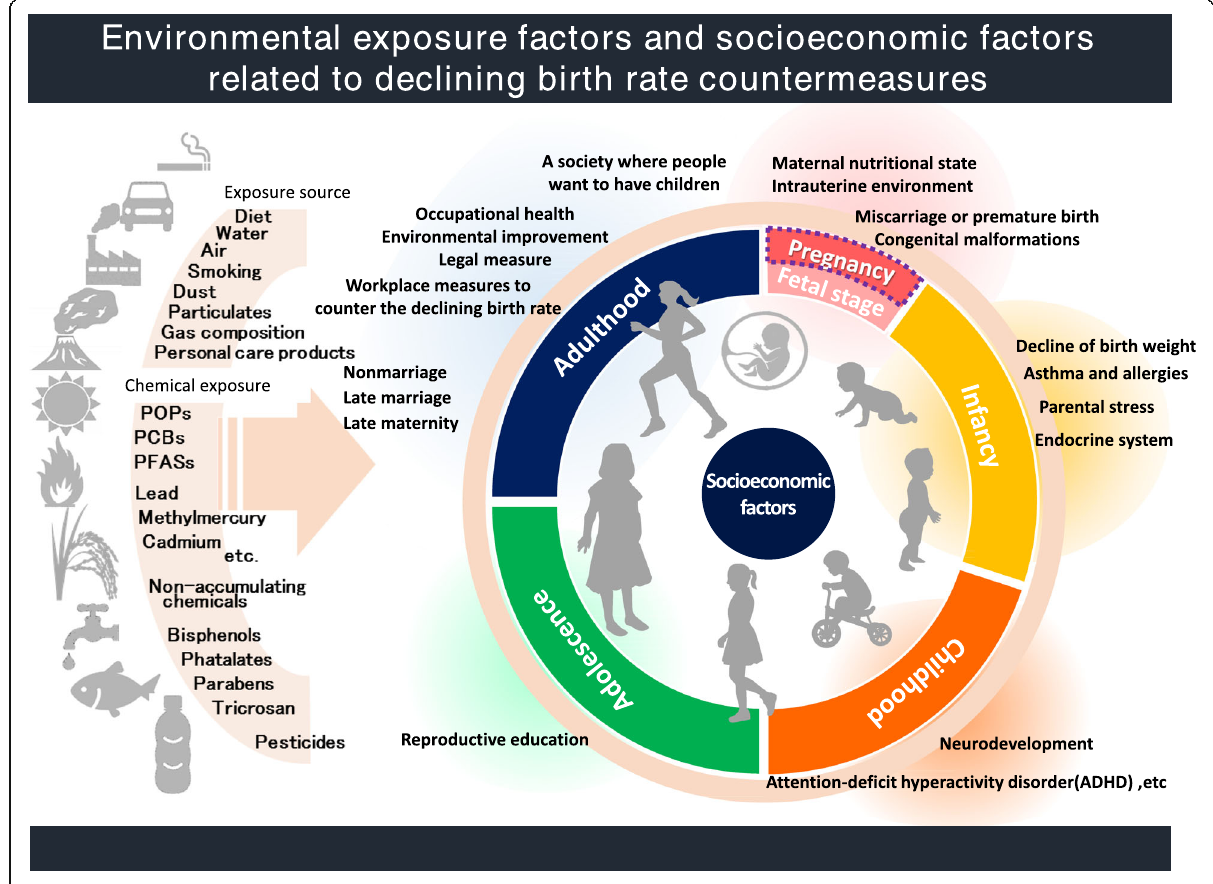
Fig. 1 Miyuki Iwai-Shimada: trends in research relating to the link between and child health